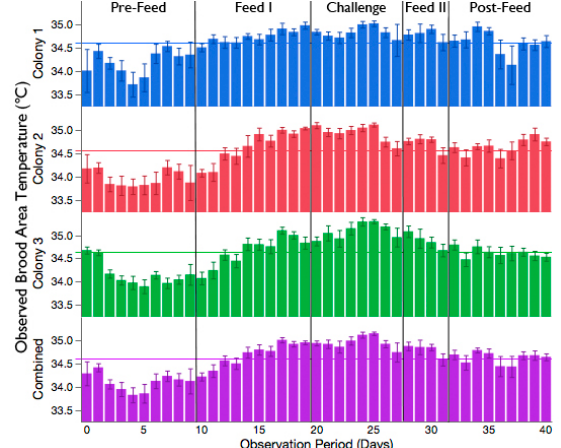
Figure 2. The daily observed temperature of the brood area for each colony and the average of the three colonies combined. Vertical lines mark the boundaries between the observation periods. Horizontal lines signify the overall mean observed temperature of the brood area for each colony and the three colonies combined. Each bar represents the mean daily temperature ± 95% CI. 3.2. Increased Brood Nest Temperature but No Reduction in Signs of Chalkbrood Disease after Challenge with A. apis